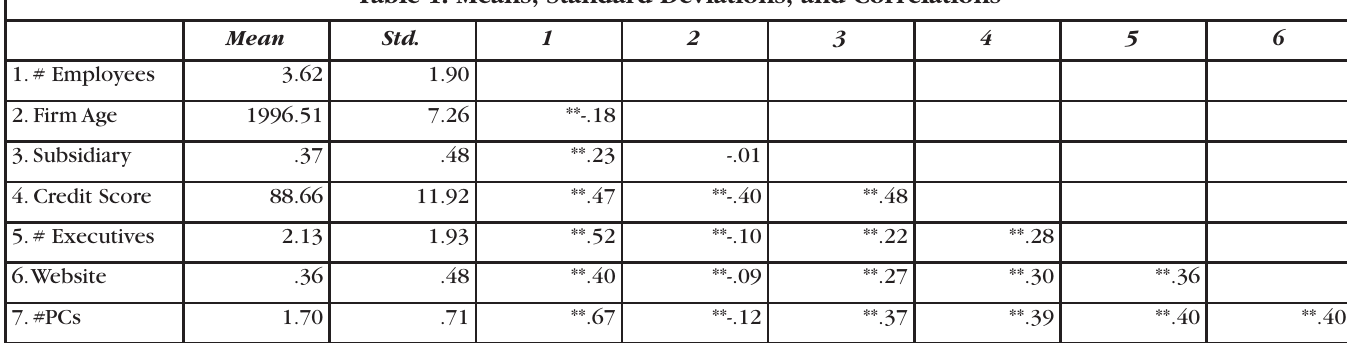
Table 1. Means, Standard Deviations, and